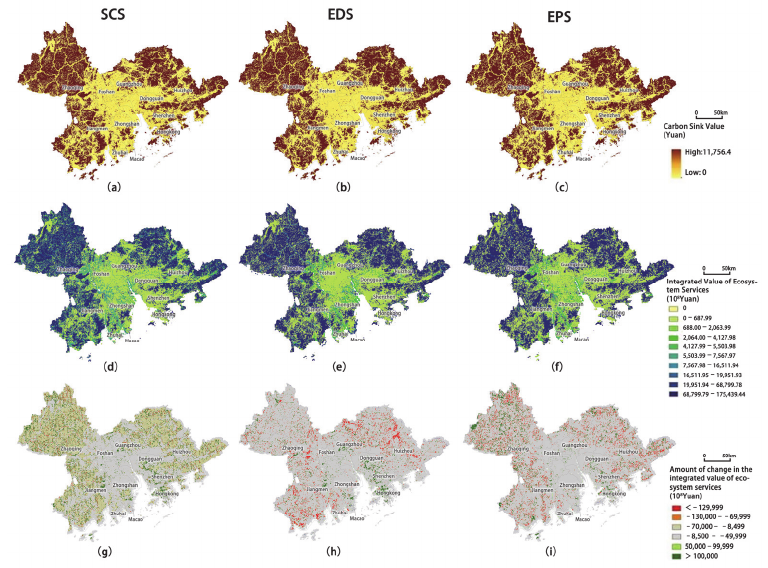
Figure 11. ( a – c ) Carbon sink values under SCS, EDS, and EPS scenarios; ( d – f ) the integrated ESVs; ( g – i ) the amount of change in the integrated ESVs.